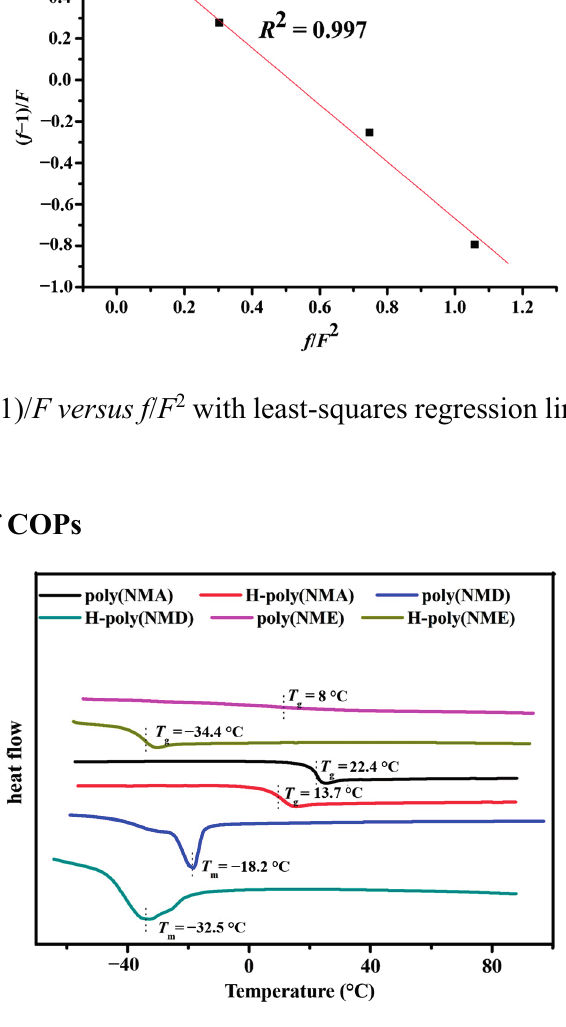
Figure A5. Differential scanning calorimetry (DSC) curves of homopolymers before and after